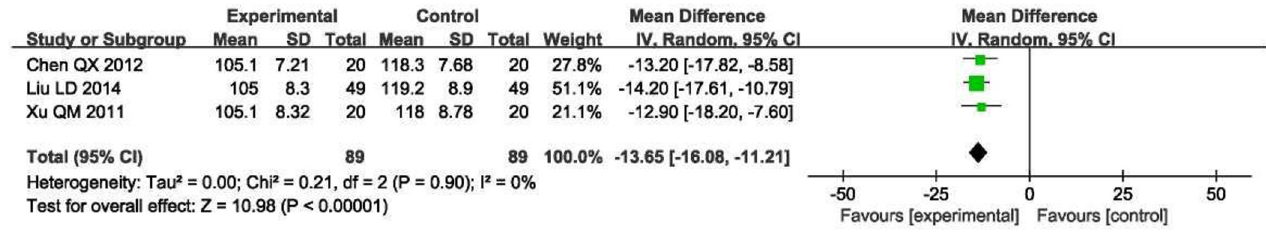
Fig 13. Forest plot of